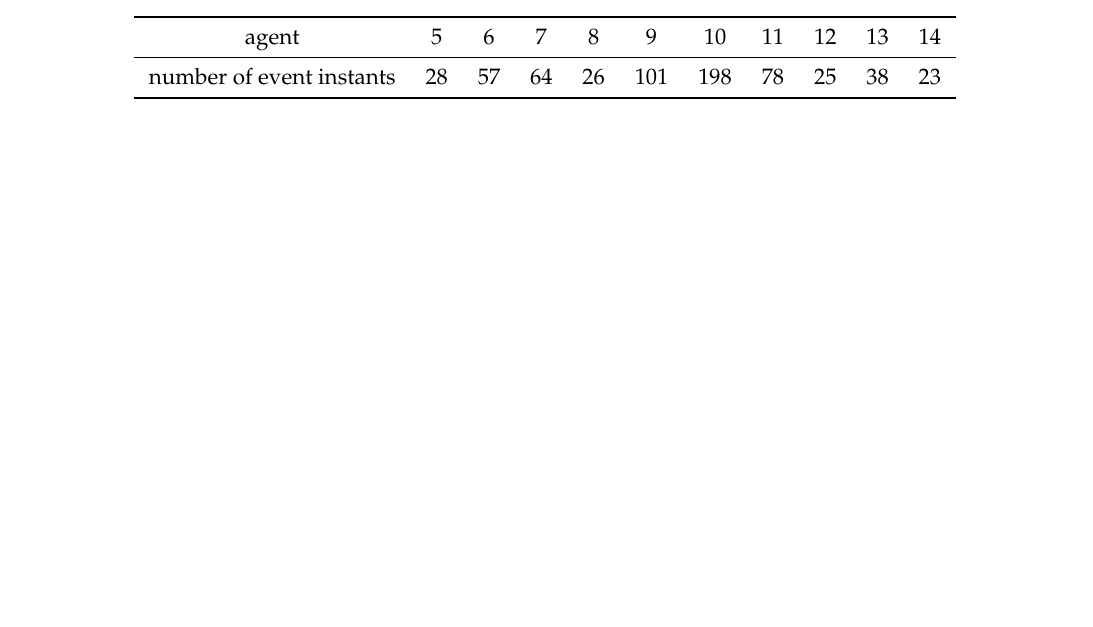
Table 2. Number of event instants of each agent ( τ = 0, 15